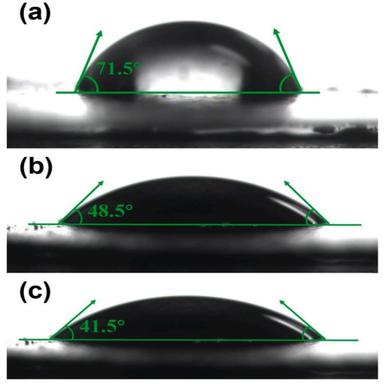
Contact angles formed by water drops on the surfaces of GR (a), hp-GR-1.0 (b) and hp-NGR-1.0 (c).